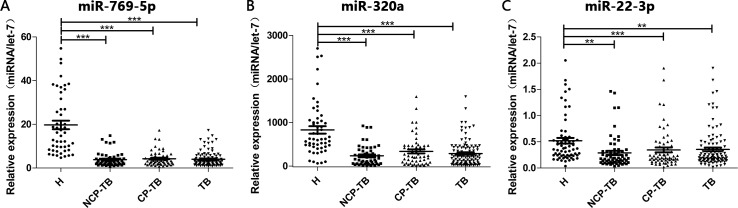
Detection of TB using 3 plasma miRNAs as a biomarker.A hydrolysis probe–based qRT-PCR assay was used to measure the relative levels of the 3 miRNAs in 64 CP-TB patients, 64 NCP-TB patients and 64 healthy controls (in both the training and validation set). Each point represents the mean of the results for triplicate. The asterisks indicate significant differences compared to healthy controls. * P<0.05; ** P<0.01; *** P<0.001. (A) miR-769-5p, (B) miR-320a and (C) miR-22-3p.